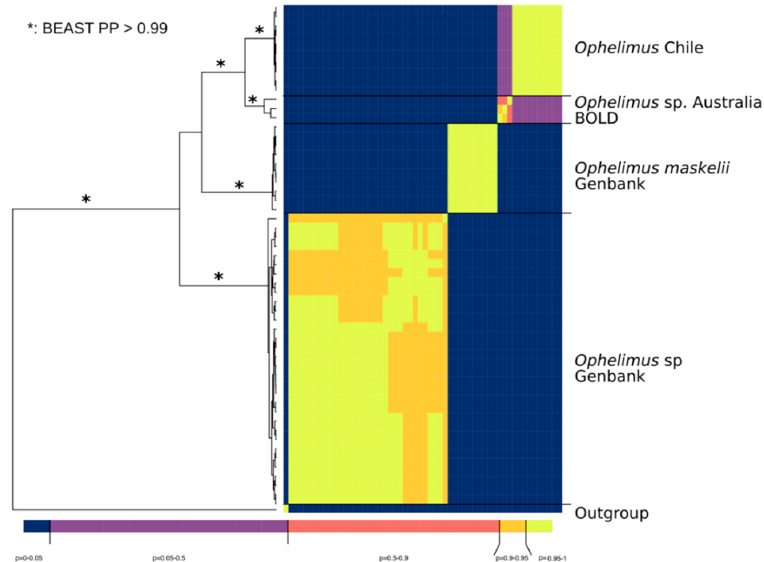
Figure 6. Ultrametric tree of inferred genealogical relationships with COI . For this tree a strict molecular clock was used in BEAST. Only those groupings with a very high significance are highlighted ( PP > 0.99).